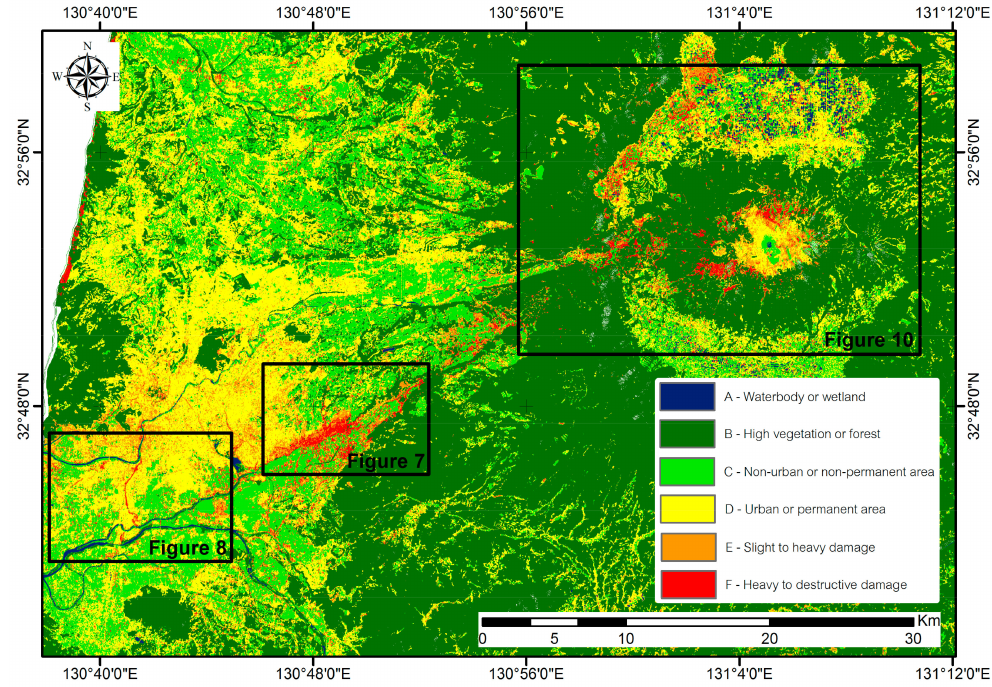
Figure 5. Classification results for the Kumamoto earthquake damage assessment. More information is presented in Section 3.1, Buildings Damaged by Ground Motion; Section 3.2, Buildings Damaged by Liquefaction, and Section 3.3, Landslide Areas.